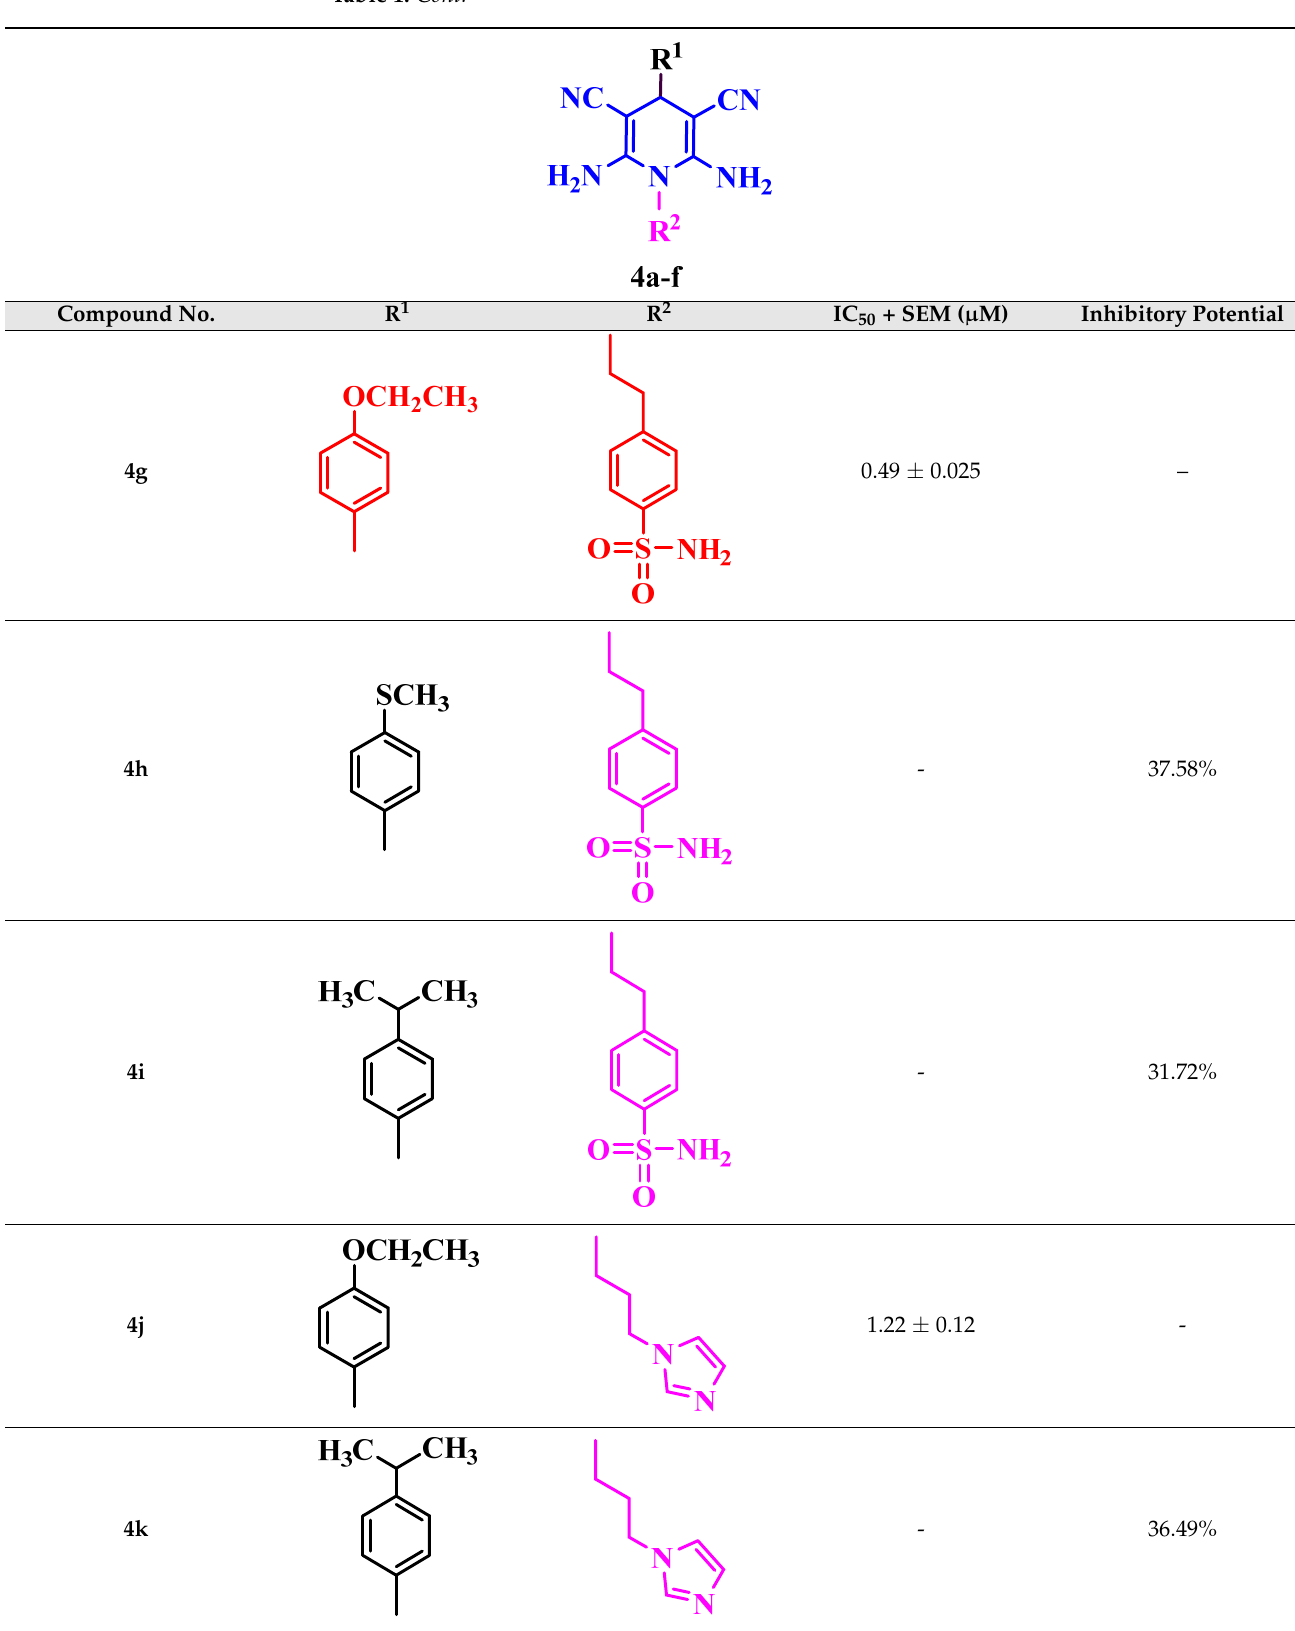
Table 1. Inhibitory potency of dihydropyridine analogs 4a ‒ 4k against human nonspecific alkaline phosphatase Table 1. Cont.